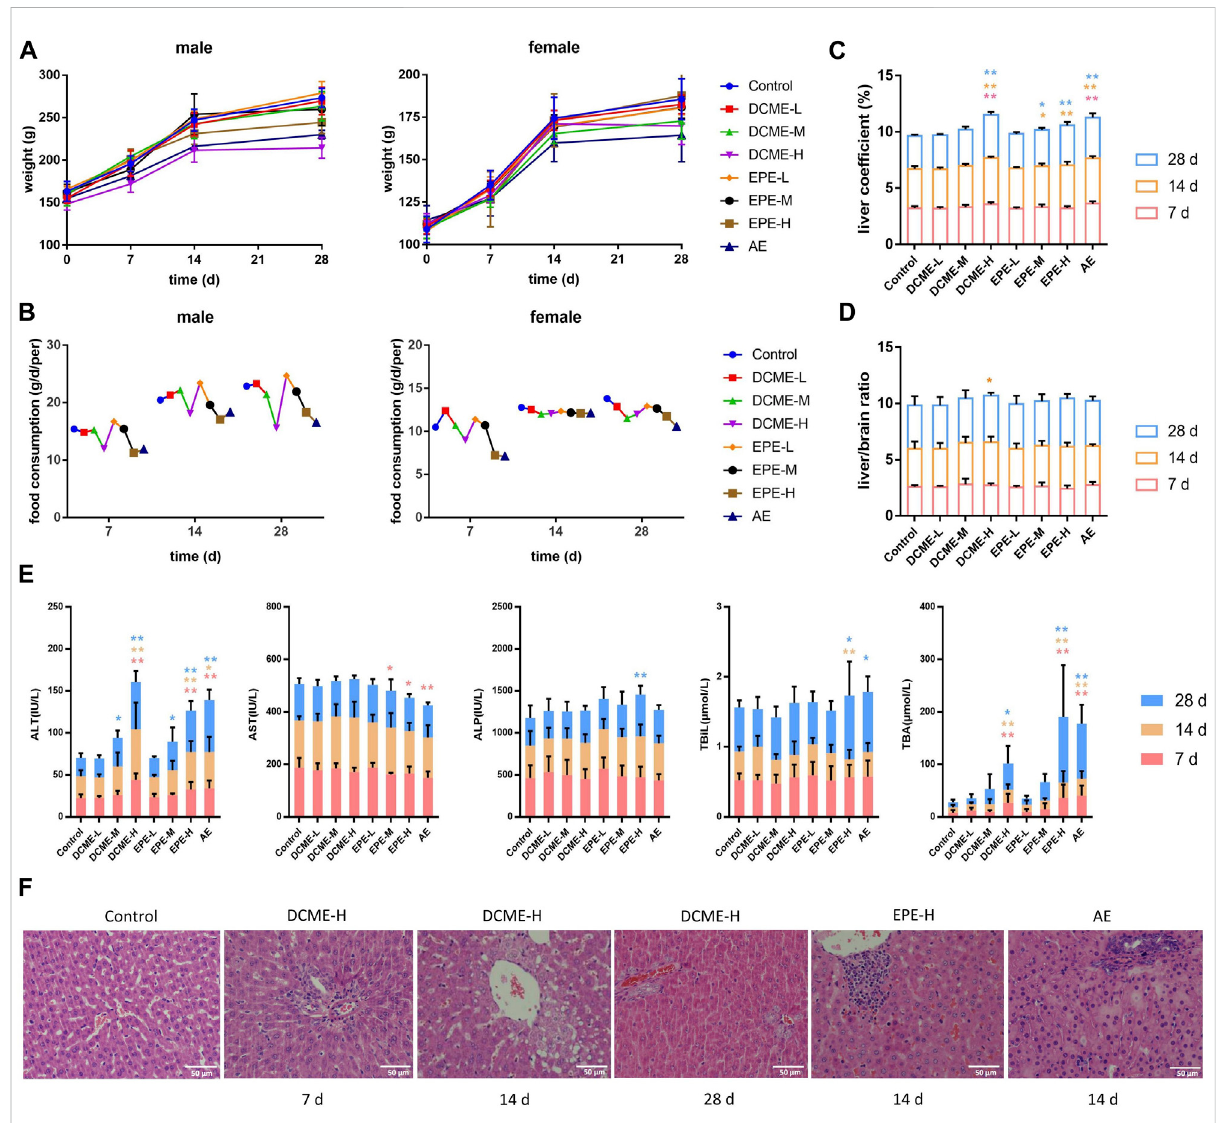
FIGURE 2 Hepatotoxic effects of different STRER extracts on rats by repeated gavage for 28 days. (A) Body weight, (B) food consumption, (C) liver coef fi cient and (D) liver/brain ratio of rats with administration during 28 days. (E) The contents of ALT, AST, ALP, TBIL and TBA in rat serums of different days. All data were presented as mean ± SD and compared with Control group. * p < 0.05; ** p < 0.01. (F) Pathological changes of liver (HE×400). Slight biliary hyperplasia, hepatic cell micro-vacuolation and mast cell in fi ltration were separately found in DCME-H group of